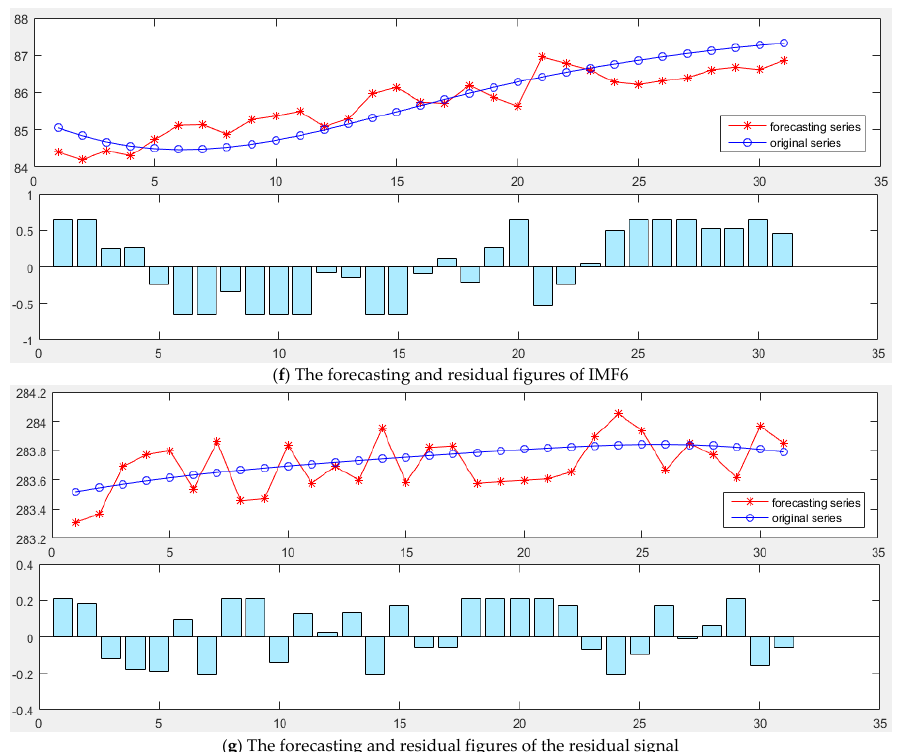
Figure 6. The forecasting results of IMFs: ( a ) IMF1; ( b ) IMF2; ( c ) IMF3; ( d ) IMF4; ( e ) IMF5; ( f ) IMF6; and ( g ) Residual.